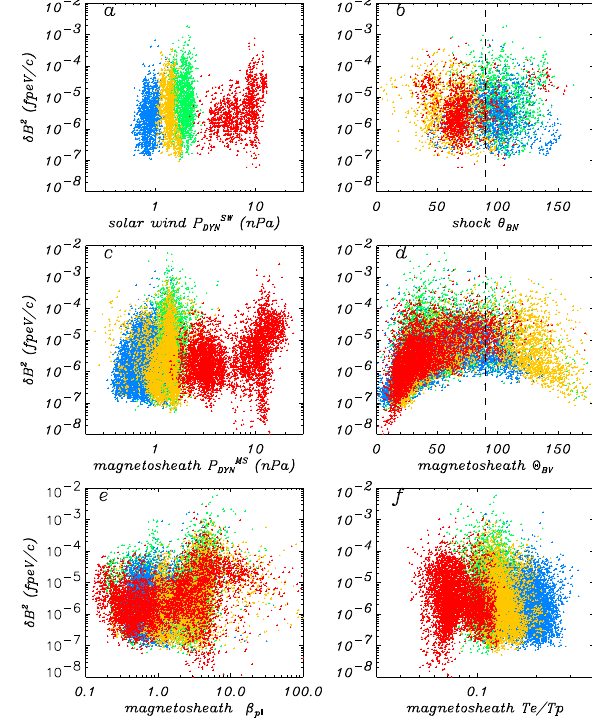
2 ( f ) Figure3:Thepowerspe traldensity(PSD)ofthemagneti (cid:29)u tuationsat11Hz, Figure4:ThePSD δB interpolatedatthetimevaryingfrequen y f pe V/c onthe SW DYN SW DYN onthefour onsidereddays,asafun tionof:a)thesolarwind P observed four onsidereddays,asafun tionof:a)thesolarwind P ,b)theupstream MS DYN every16sonACE,about1hourearlier,b)theupstreambowsho kangle θ BN ,d)theangle Θ BV ,e)the bowsho kangle θ BN , )themagnetosheath P MS DYN 2 (f ) interpolated at the time varying frequency Fig. 3. The power spectral density (PSD) of the magnetic fluctu- every16s, )thelo almagnetosheath P every4s,d)thelo alangle Θ BV magnetosheath β p k ,f)theratio T e /T p .4 Fig. 4. The PSD δB between B and V ,e)thelo al β p k ,f)thelo alratio T e /T p . f pe V/c on the four considered days, as a function of: (a) the solar ations at 11Hz, on the four considered days, as a function of: (a) the solar wind P SW observed every 16s on ACE, about 1h ear- wind P SW , (b) the upstream bow shock angle θ BN , (c) the mag- 3 DYN DYN lier, (b) the upstream bow shock angle θ BN every 16s, (c) the local netosheath P MS , (d) the angle 2 BV , (e) the magnetosheath β p k , DYN magnetosheath P MS every 4s, (d) the local angle 2 BV between (f) the ratio T e /T p DYN B and V , (e) the local β p k , (f) the local ratio T e /T p .